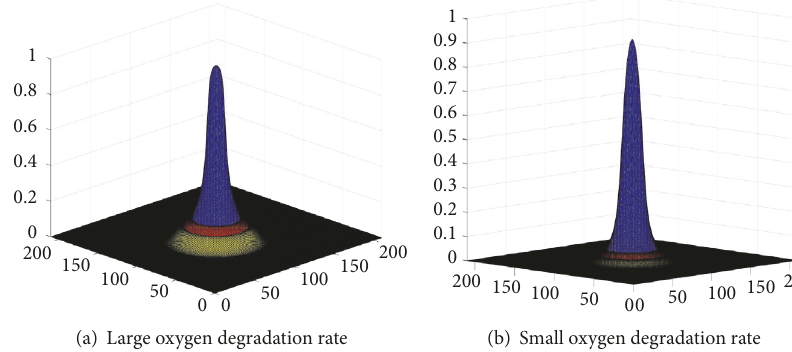
Figure 14: Impact of oxygen degradation rate on the growth of the tumor at 𝑡 = 20 : (a) 𝑘 1 = 0.15 ; (b) 𝑘 1 = 0.03